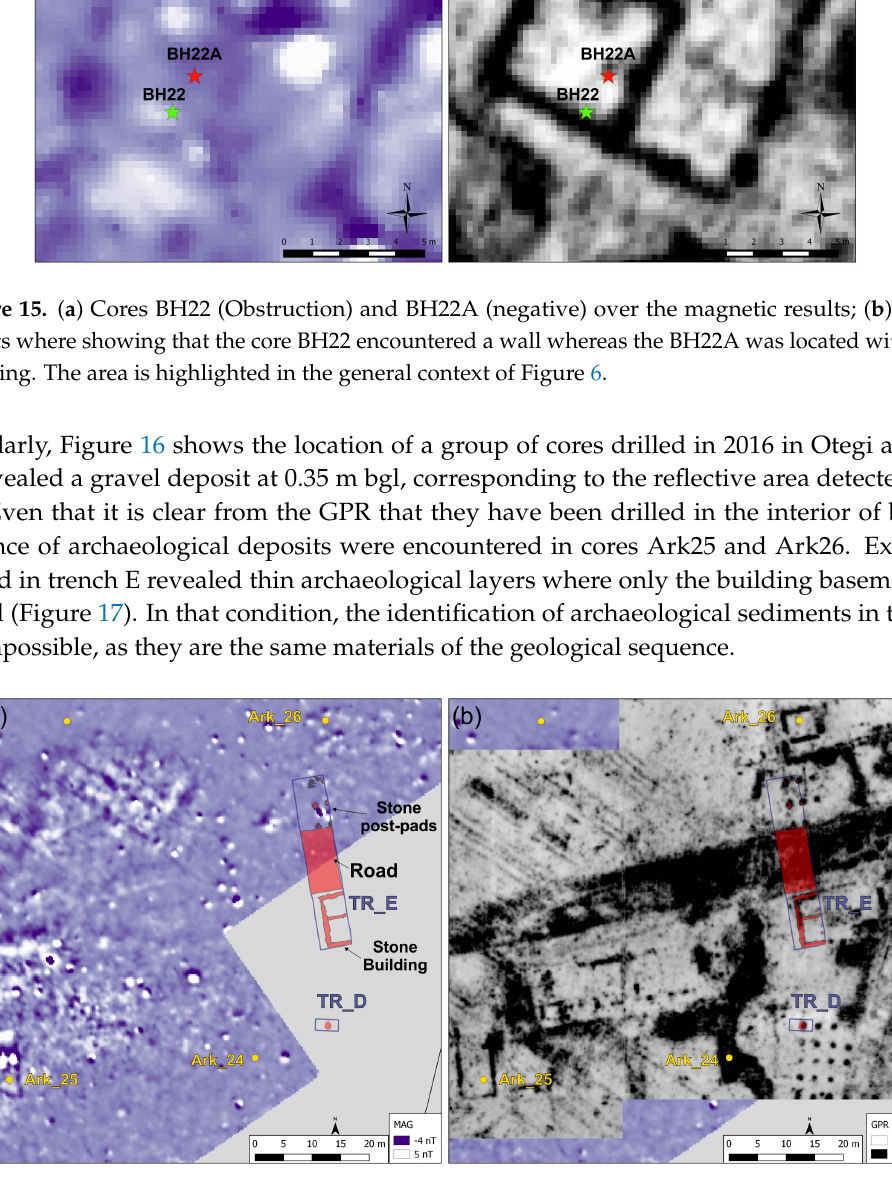
Figure 16. Detail of cores drilled in Otegi area in 2016. The trenches D and E (TR_D and TR_E, respectively), together with the significant encountered archaeological features are also indicated. The area is highlighted in the general context of Figure 6. ( a ) Over the magnetic results; ( b ) Over GPR results (time-slice at 0.38–59 m bgl, v = 8.1